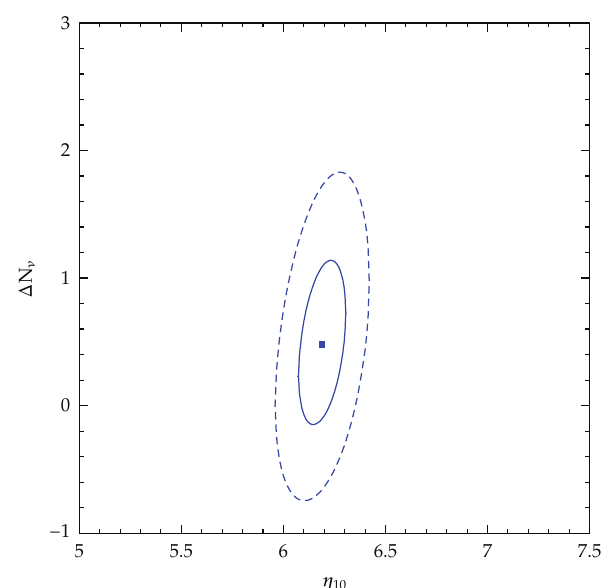
Figure 9: The 68% (cid:3) solid (cid:4) and 95% (cid:3) dashed (cid:4) contours in the Δ N ν - η 10 plane derived from BBN deuterium and the CMB constraint on the baryon density (cid:5) 38 (cid:6)